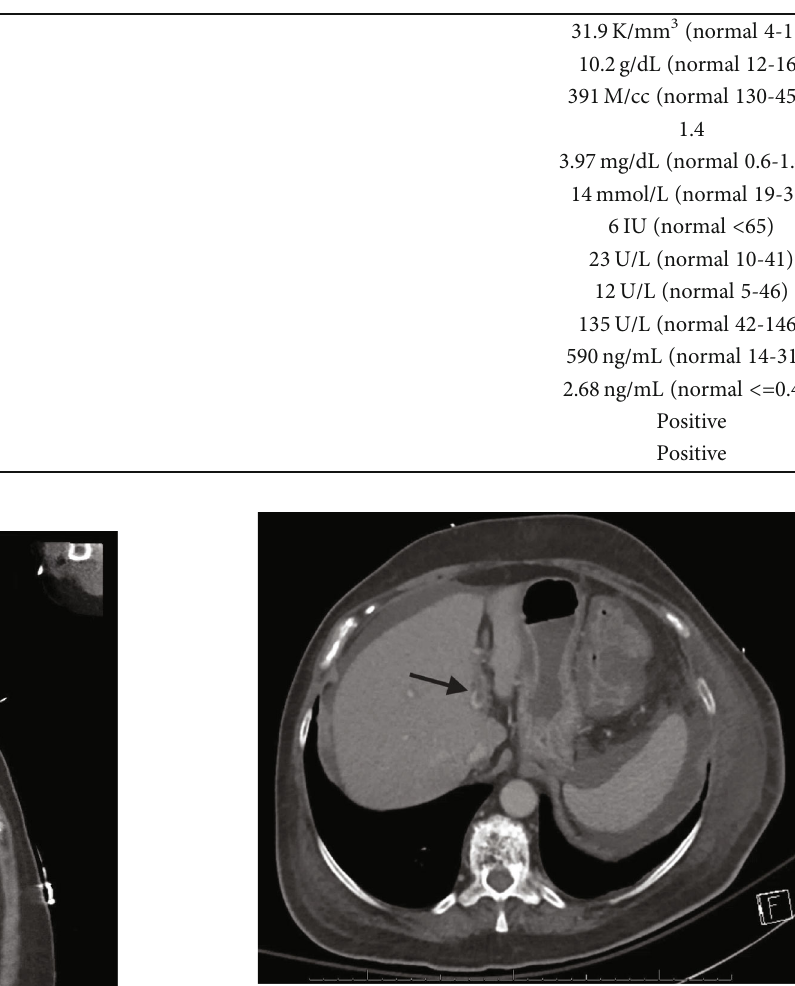
Table 1: Labs on admission.